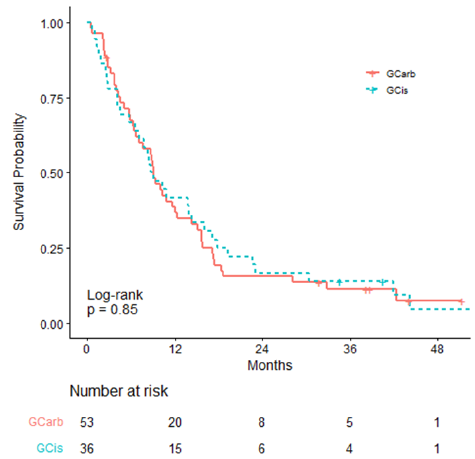
Figure 3. Overall survival in patients receiving first-line palliative therapies. ( a ) OS calculated from date of metastasis. ( b ) OS calculated from initiation of first-line therapy. Chemotherapy (1L CT), immunotherapy (1L IT) or no treatment (1L NT).